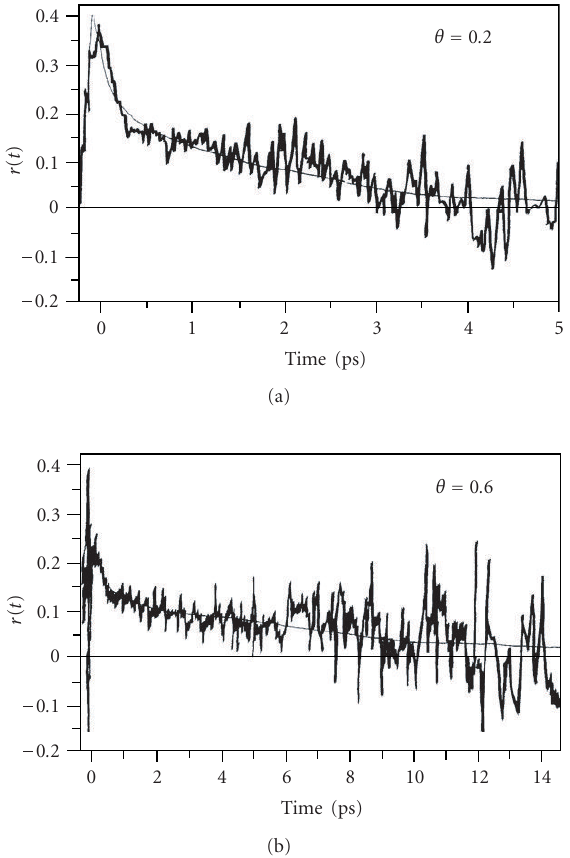
Figure 9: The polarization function r ( t ) as derived from the time- resolved fluorescence intensity of the dye in Figure 2, which formed J -aggregates on silver bromide grains with variation of surface cov- erage ( θ